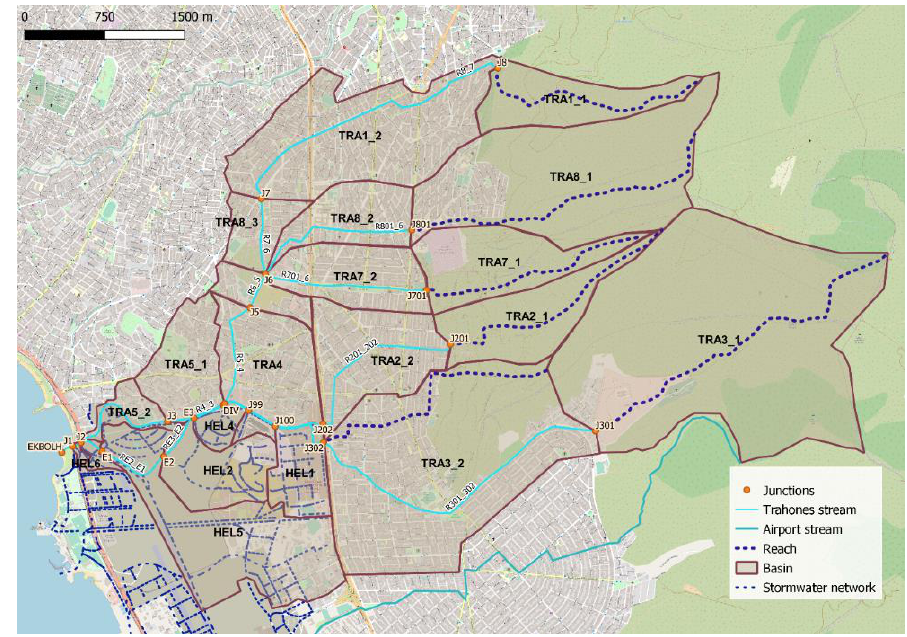
Figure 2. Hydrological modeling system of Trachones stream.